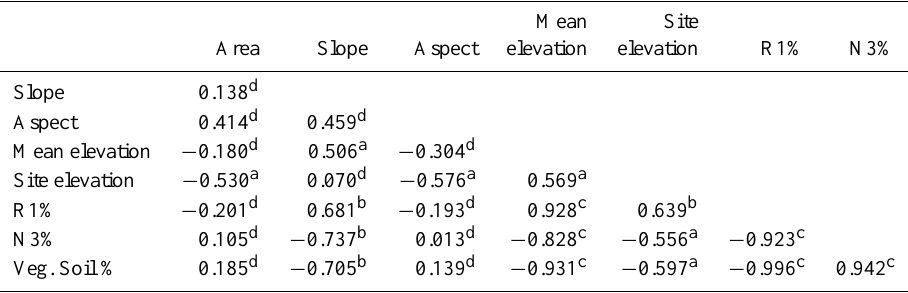
Table 3. Summary of Pearson product–moment correlations among catchment landscape